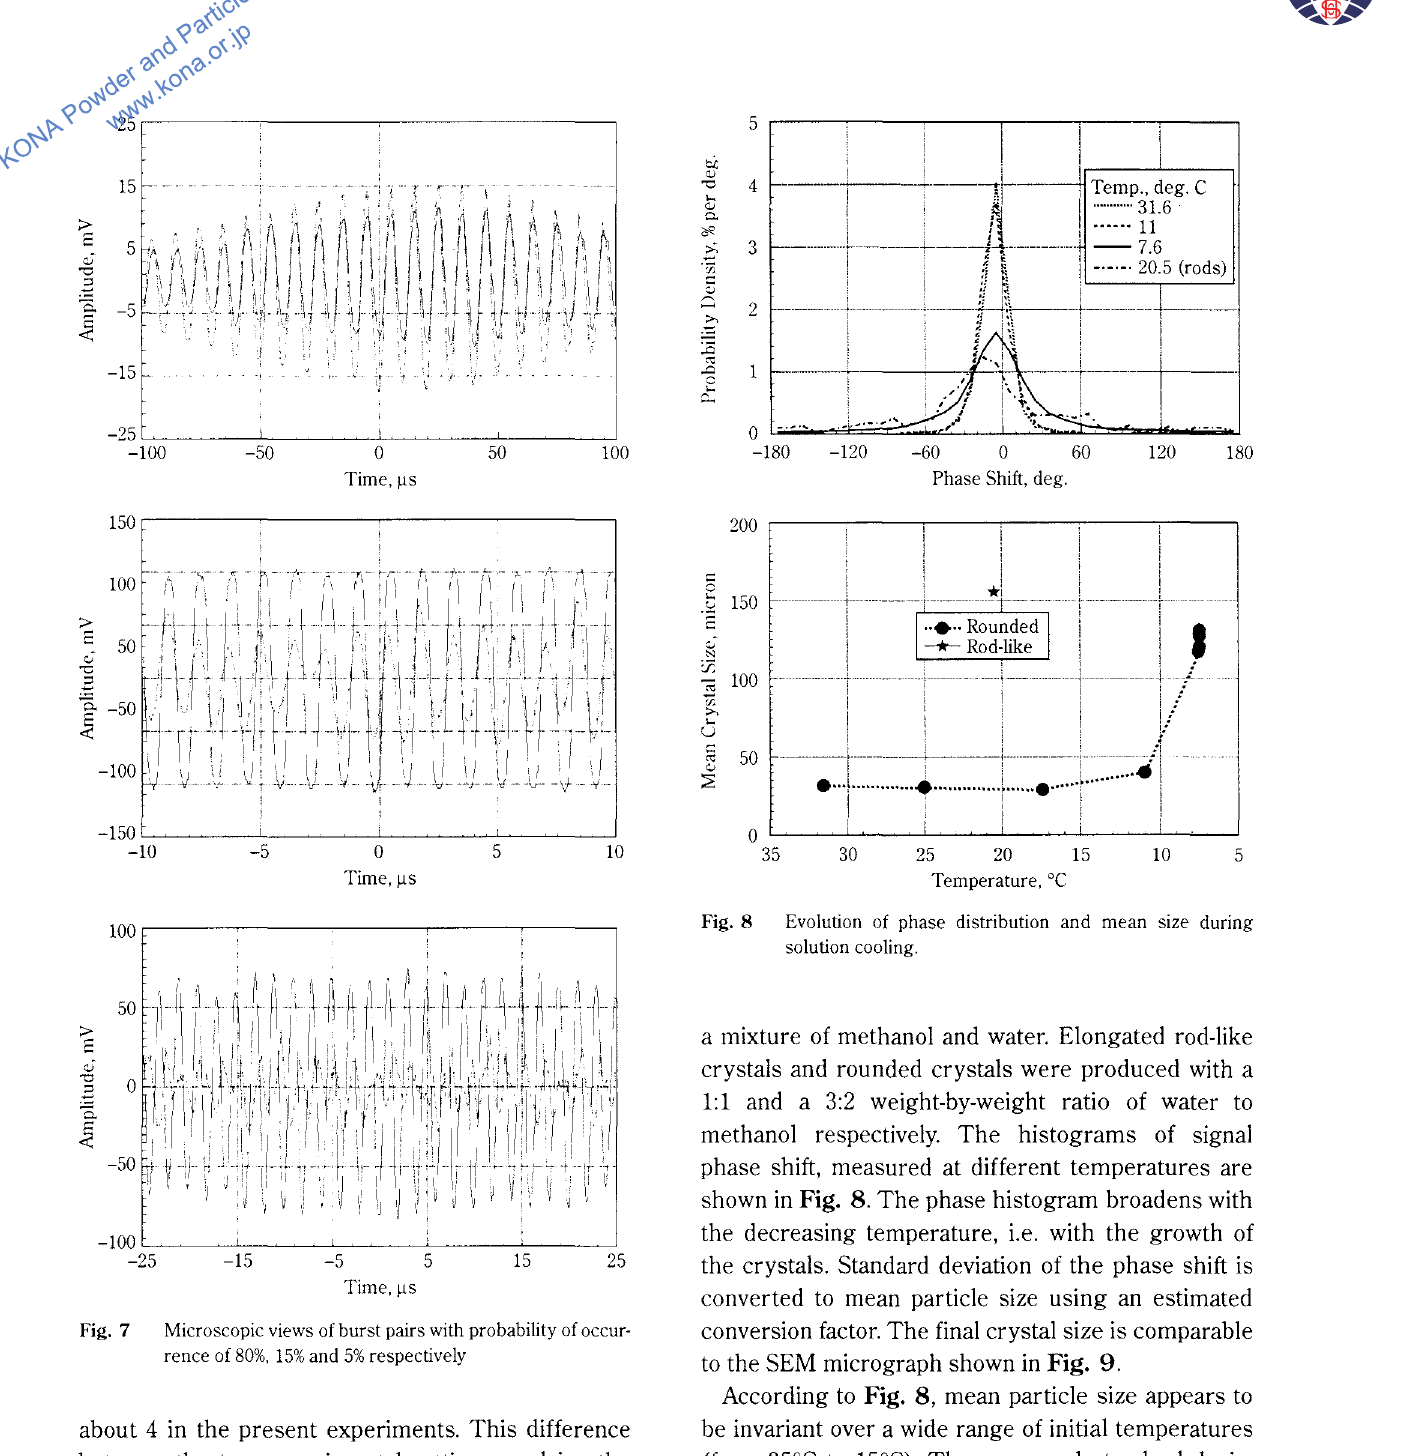
Microscopic views of burst pairs with probability of occur rence of 80%, 15% and 5% respectively